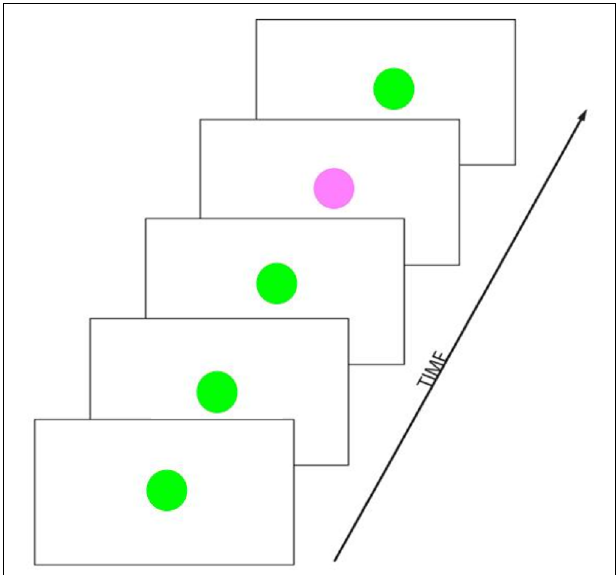
FIGURE 4 | Example of an oddball paradigm in the visual domain. Visual stimuli are presented in a temporal sequence.The green colored circle stimulus is frequently presented and is referred to as the “frequent” or “standard” stimulus.The pink colored circle is rarely presented and is referred to as the “rare” or “deviant” or “target” stimulus.The number of standards presented between two deviants is pseudo-random.